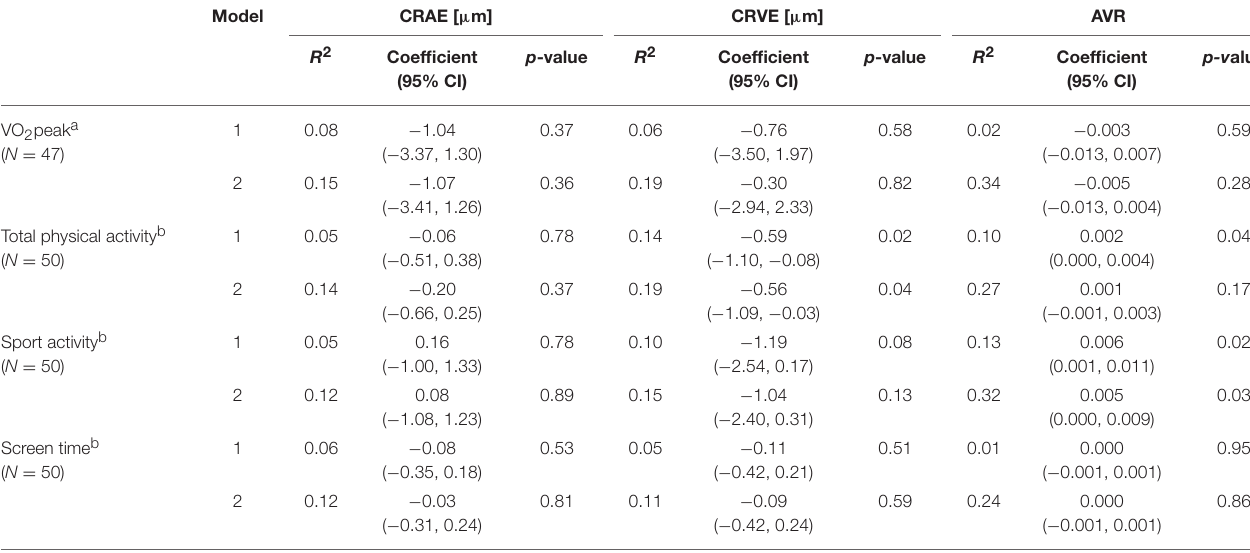
TABLE 3 | Influence of fitness and activity parameters on retinal